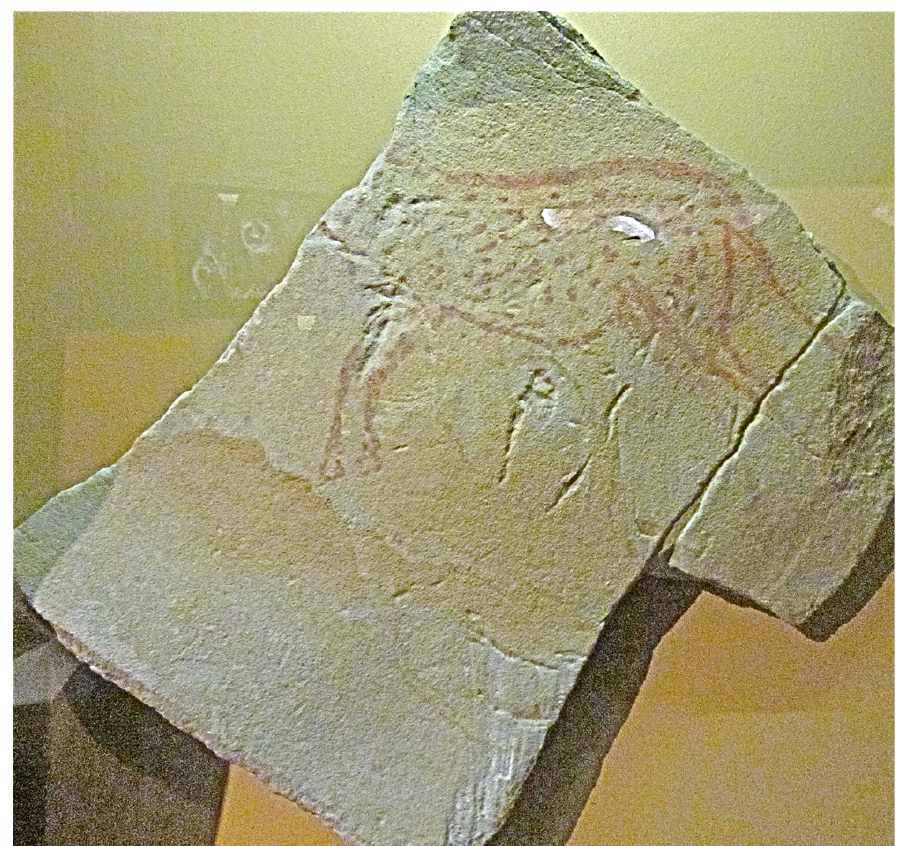
Figure 5. Sandstone slab from Boutigny- sur-Essone. Now in the Museum of Saint Germain-en-Laye. Size: 46 cm by 35 cm. Photograph by B.